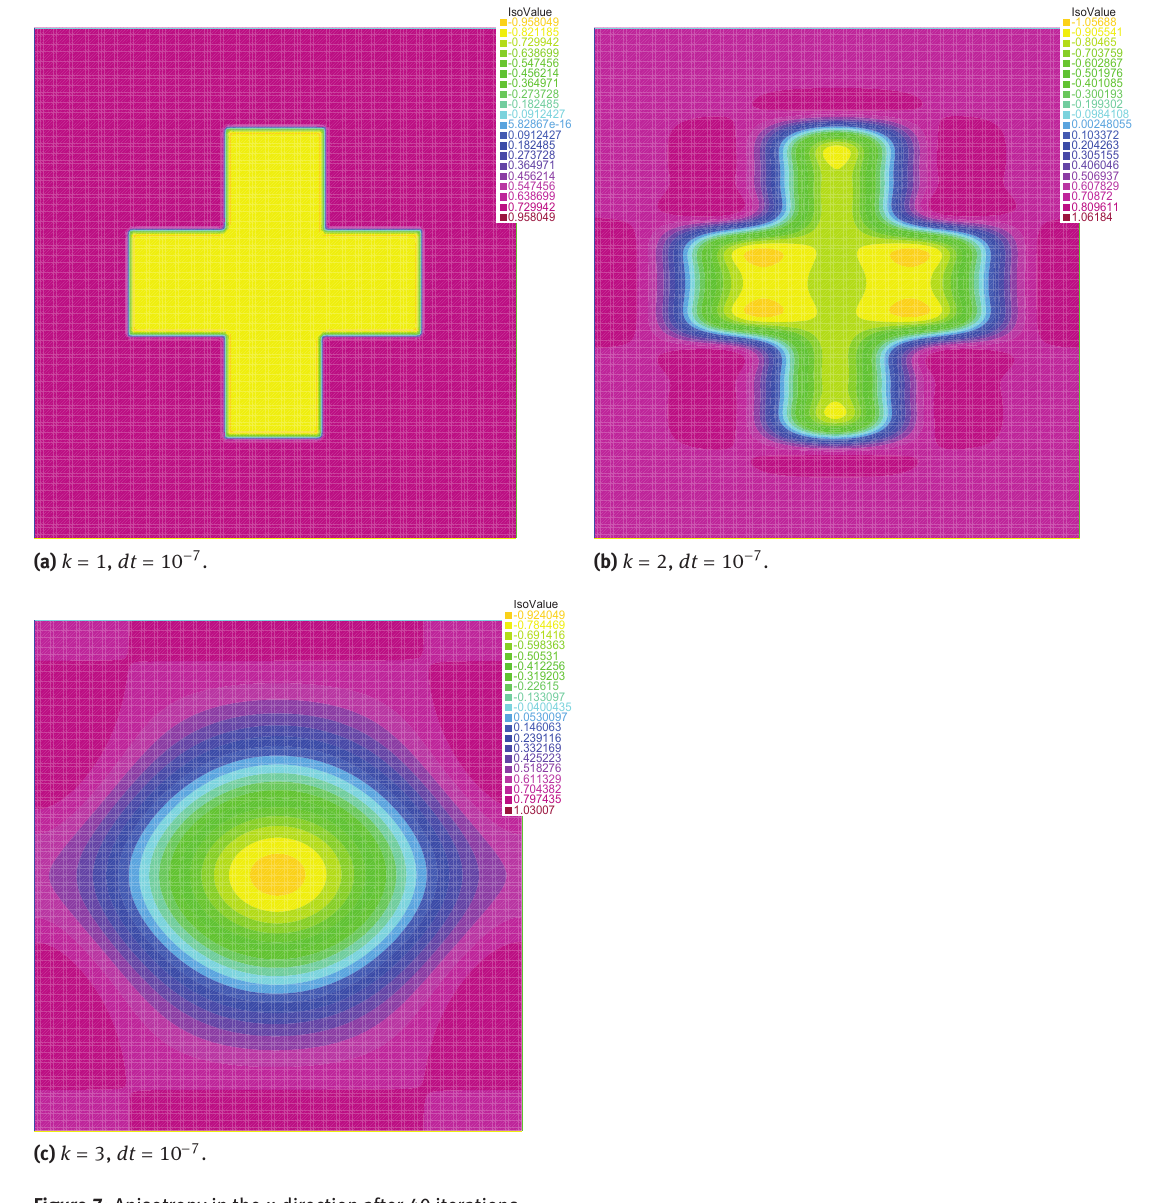
Figure 7: Anisotropy in the x -direction after 40